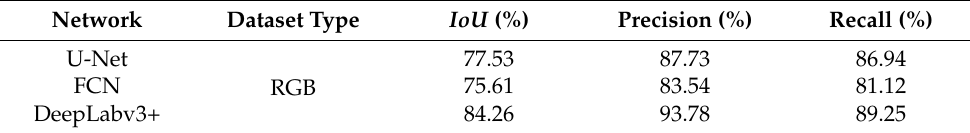
Table 4. The segmentation performance of different networks.